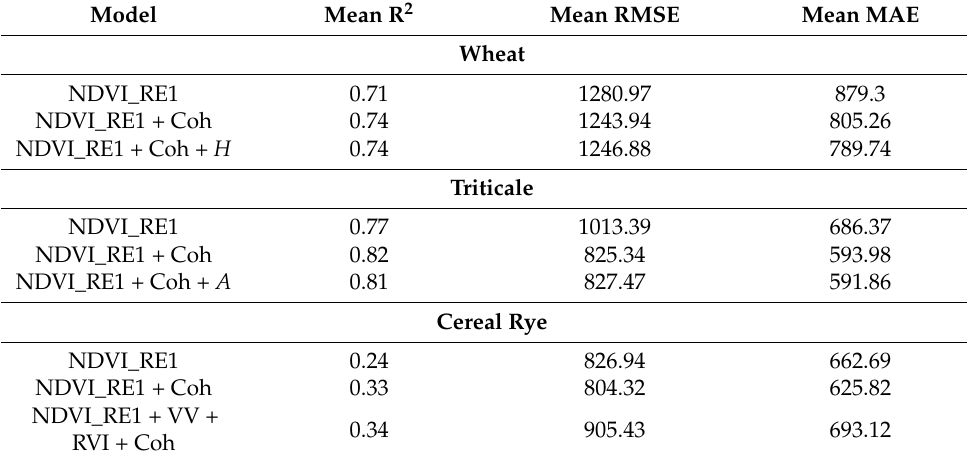
Table 6. Results of combined optical and synthetic aperture radar (SAR) analysis of variance cross- validation. Models combined the normalized difference red-edge index using band 5 (NDVI_RE1) optical index and the best SAR metrics—InSAR coherence (Coh), entropy ( H ), anisotropy ( A ), vertical- vertical backscatter (VV), and the radar vegetation index (RVI). We split the data into 70% train and 30% test splits to estimate goodness of fit (adjusted R 2 ) and error (RMSE, MAE). We iterated these splits 100 times and reported the mean